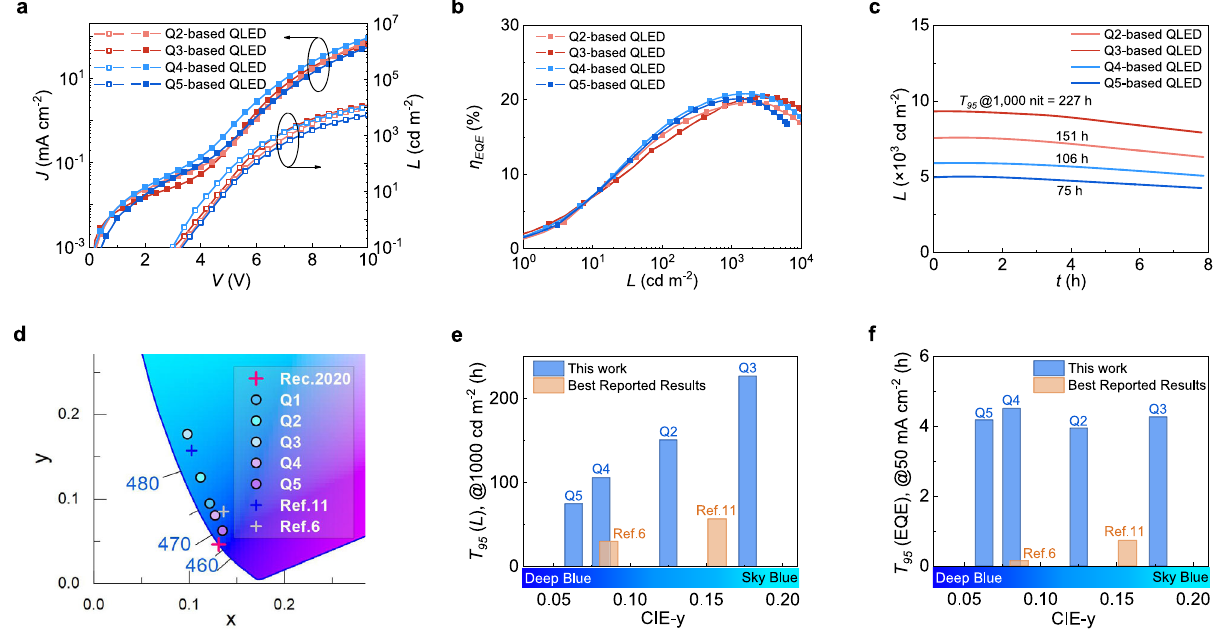
Fig. 3 | Blue QLEDs with record-high operational lifetimes. a L - J - V character- istics. b External quantum ef fi ciencies (EQEs). c Luminance decay of blue QLEDs based on Q2, Q3, Q4, and Q5. The current density is set at 50 mA cm − 2 . d The CIE- 1931 coordinates of Q1-, Q2-, Q3-, Q4, and Q5-based QLEDs (circles fi lled with different colors). The coordinates of the best-reported sky blue (ref. 11 , the blue cross symbol), the best-reported near-Rec.2020-standard blue QLEDs (ref. 6 , the graycrosssymbol),andtheRec.2020standardblue(theredcrosssymbol)arealso marked. The reference data is extracted from the published graphs. e